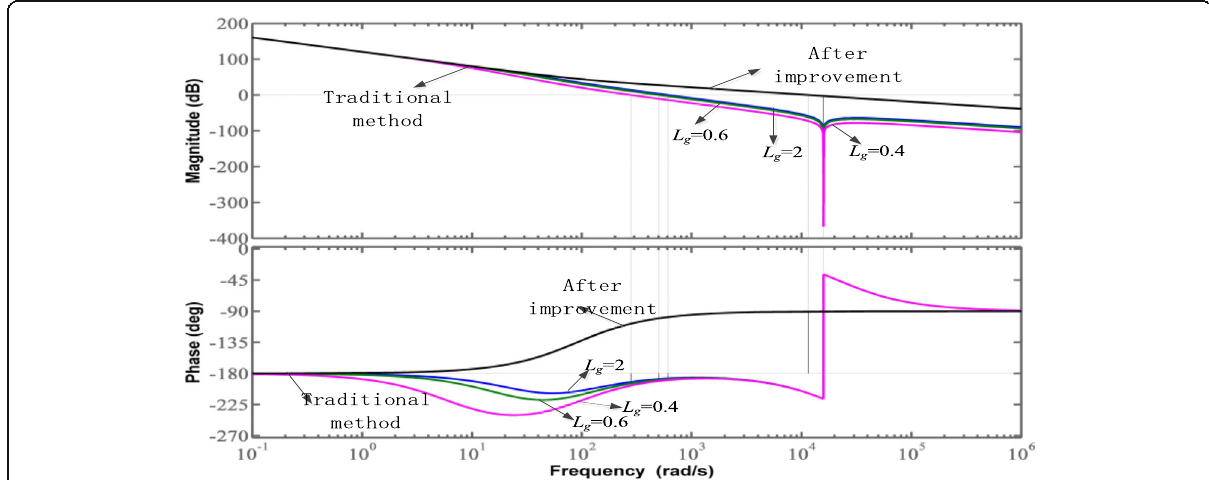
Fig. 8 Bode diagram of weighted average current before and after